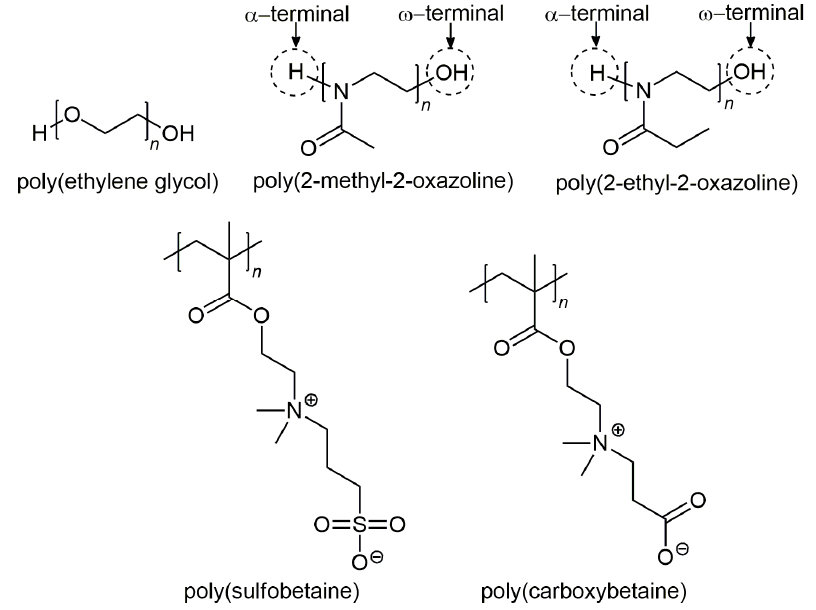
Figure 2. Chemical structures of the stealth polymers. The alpha ( α ) and omega ( ω ) termini of poly(2-methyl-2-oxazoline) and poly(2-ethyl-2-oxazoline) are indicated in circles.